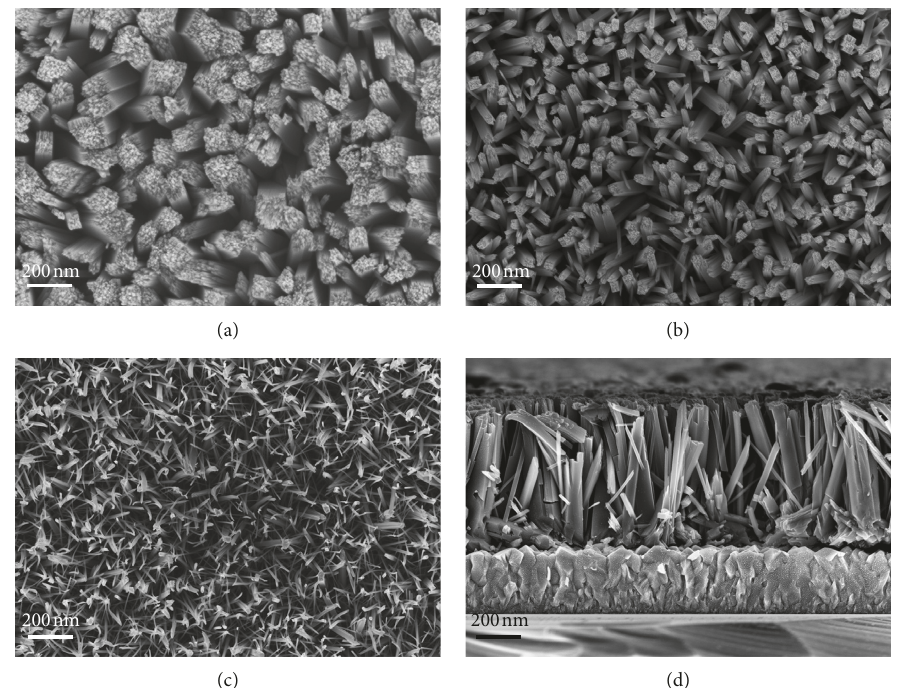
Figure 1: FESEM images of TiO x -NRs, which were made by different concentrations of HCl: (a) 4 M, (b) 5M, (c) 6M, and (d) the cross section of